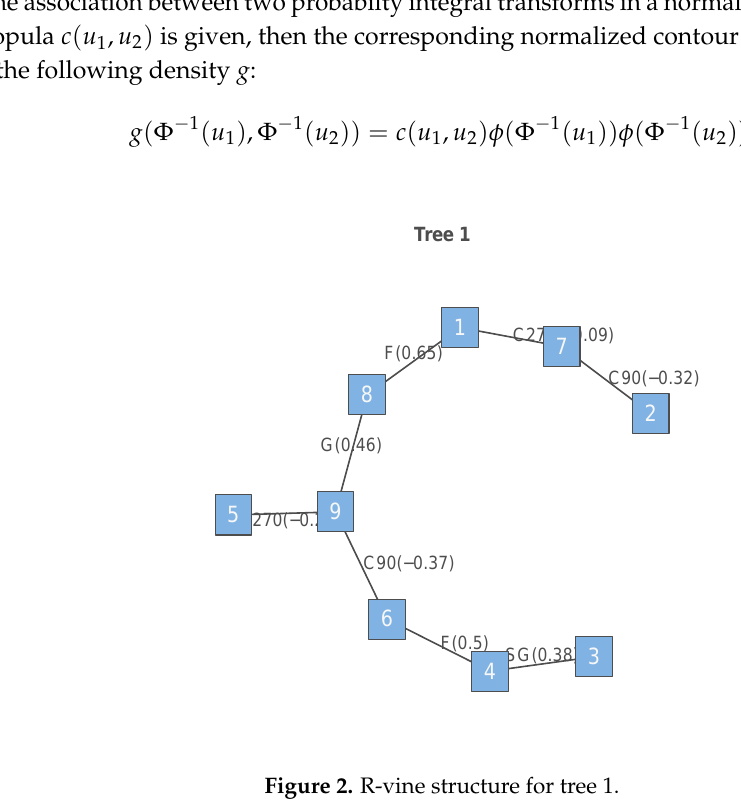
Figure 2. R-vine structure for tree